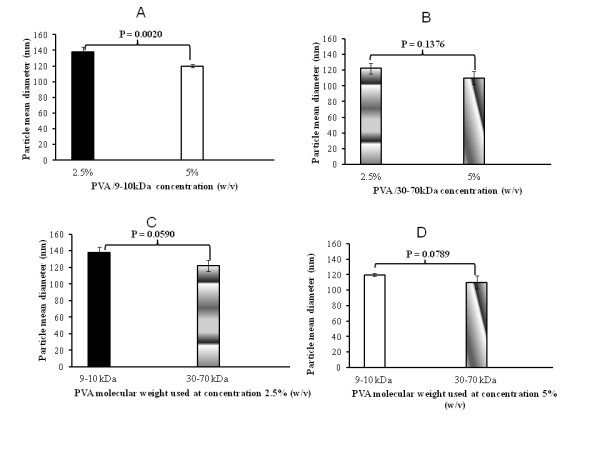
Influence of PVA concentrations (A, B) and molecular weights (C, D) on the blank NC mean diameter. This is detected by DLS (n = 3; S.D.: standard deviation between the three assays).